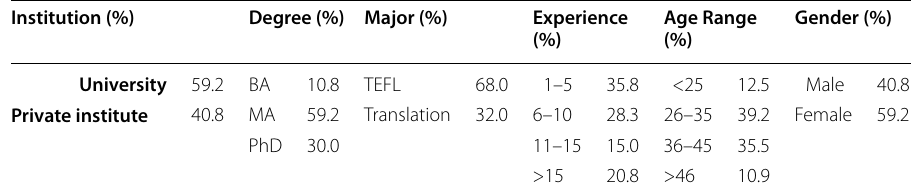
Table 1 Demographic attributes of the participants